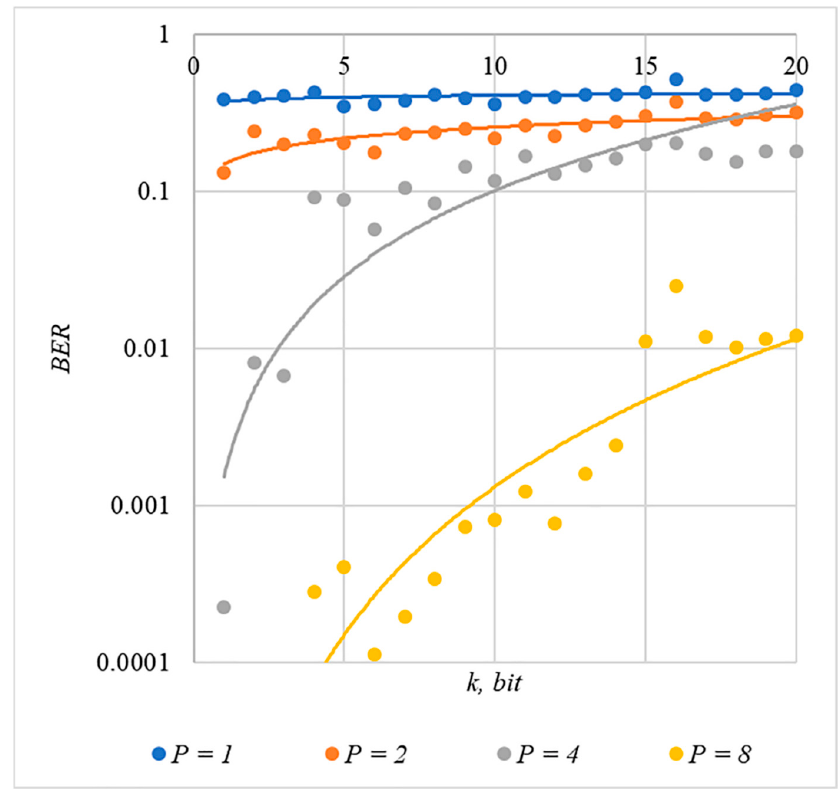
P rule for generating chip codes № 4. Figure 5. BER ( k ) dependencies for different values of